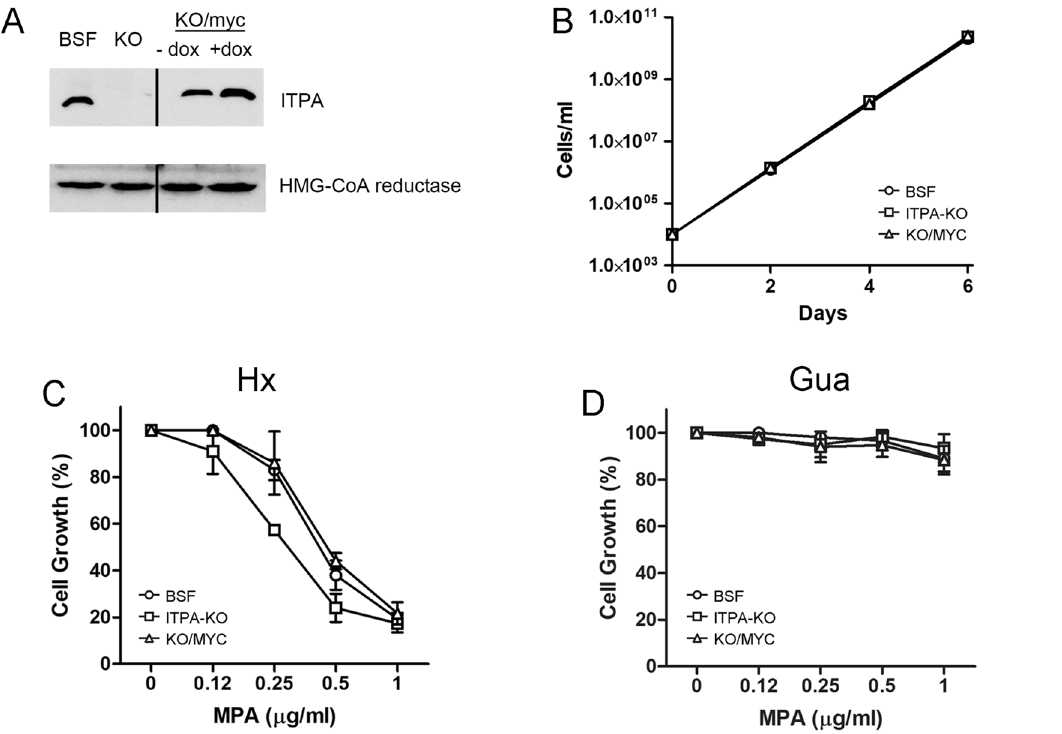
Figure 3. Effect of ITPA inactivation in bloodstream T. brucei cells. ( A ) Western blot showing ITPA protein levels in whole cell extracts from 5 × 10 6 parasites. ITPA was detected with the anti-ITPA polyclonal antibodies. Cell lines analyzed include: wild-type bloodstream form (BSF), ITPA-KO cells (KO) or ITPA-KO cells harboring an ectopic inducible copy of a myc-ITPA fusion gene (KO/myc) in the absence (− dox) or presence (+ dox) of the inductor. As loading control, HMG-CoA reductase protein was measured in a separate gel with anti-HMG-CoA reductase polyclonal antibodies. Images were cropped and aligned for easier comparison. ( B ) Cumulative cell growth over a six-day period of trypanosomes cultured in standard HMI-9 medium in vitro. KO/myc cell line was grown in the presence of the inductor. Data represent the mean for three independent biological replicates. ( C , D ) Log-phase parasites at 10 5 cells mL −1 were exposed to increasing concentrations of mycophenolic acid (MPA) for 24 h at 37 °C in HMI-9 medium containing ( C ) hypoxanthine (1 mM) or ( D ) modified HMI-9 medium containing guanine (100 µM) as the sole purine source. Proliferation was calculated relative to cell growth in the absence of MPA for each cell line. Experiments were performed at least three times, values are the mean (± SD). Cell lines are represented with the following symbols: BSF (circle), ITPA-KO (square), KO/myc- ITPA in the presence of 1 μg mL −1 of doxycycline